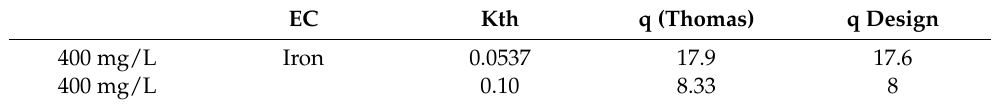
Table 7. Comparison of the parameters of the Thomas model and design model.